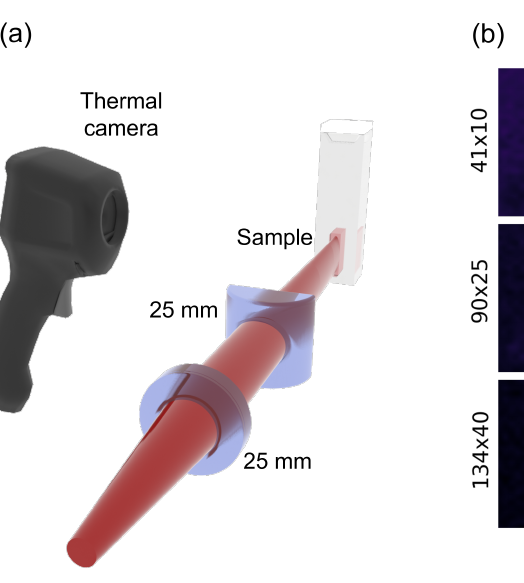
Figure 3. ( a ) Experimental details picturing the light sheet optics and the positioning for temperature acquisition. ( b ) Thermographic stills of the specimens during laser irradiation for temperature distributions in the AuNR samples and surroundings after 0, 5 and 20 min. The rectangles delineate the specimen location in the cuvette. The colorbar (virtual) restricts the range of temperature change in all